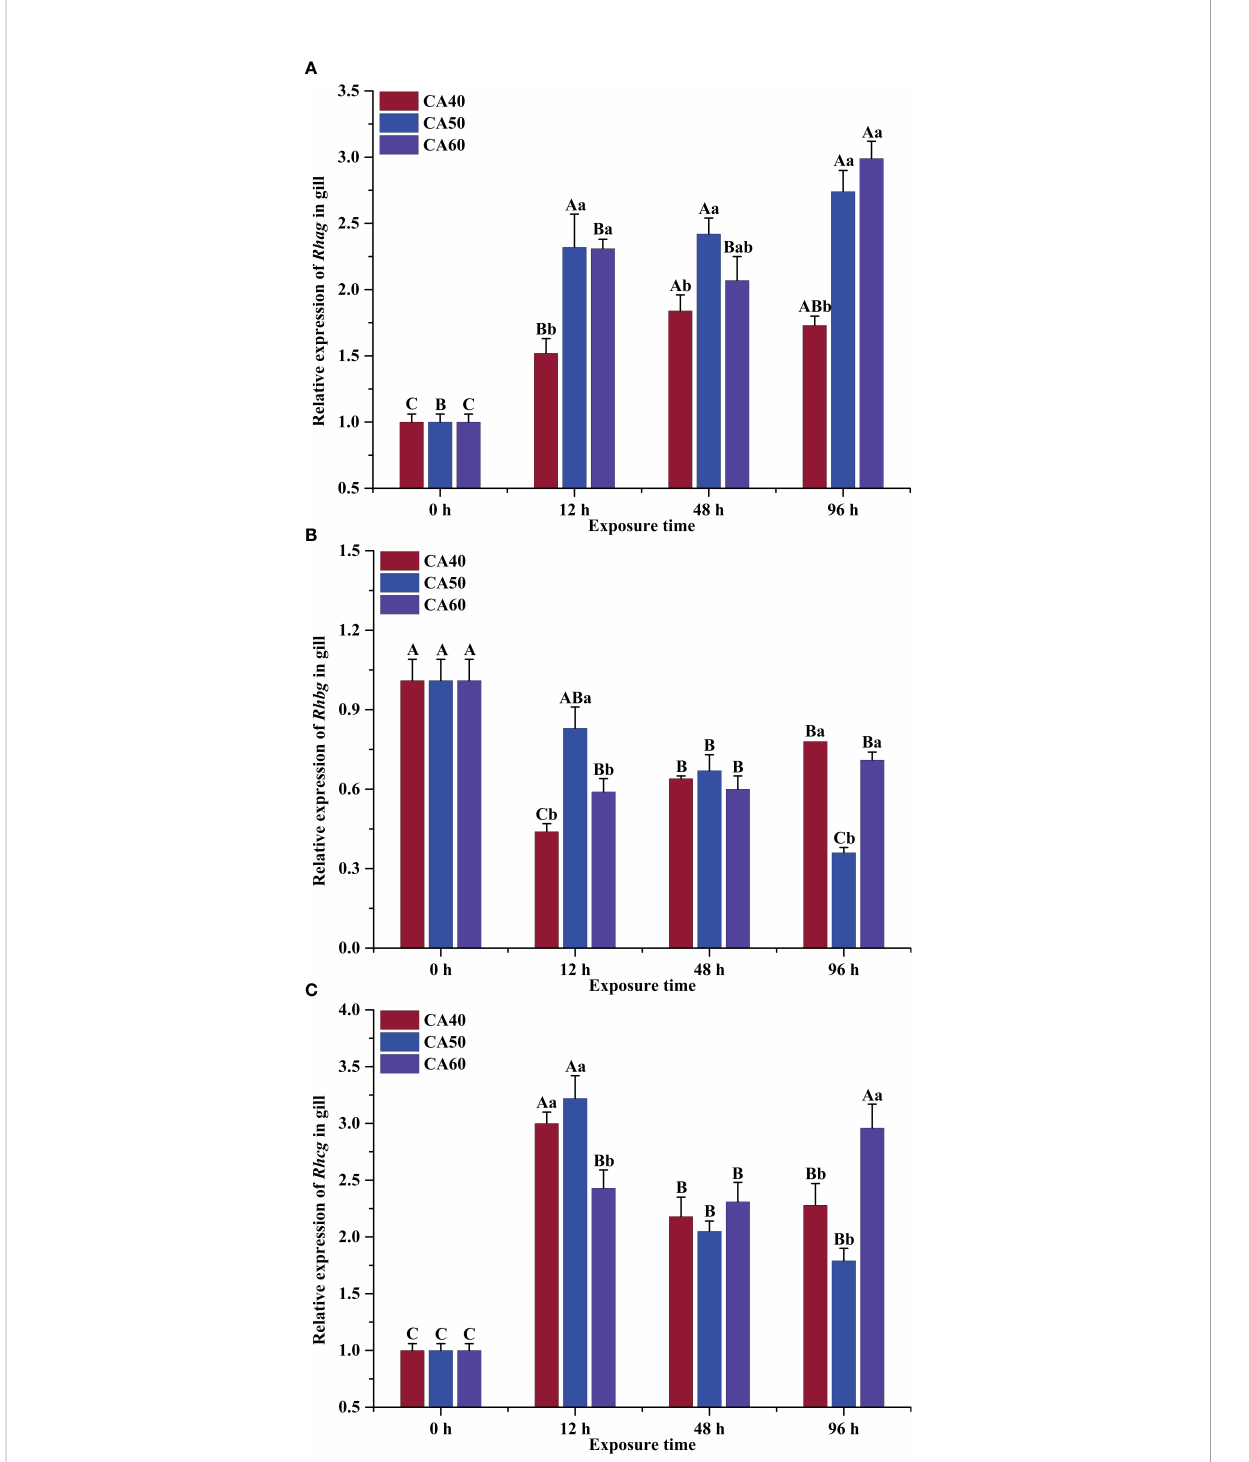
FIGURE 1 Effects of carbonate alkalinity (CA) on the relative expression of Rhag (A) , Rhbg (B) and Rhcg (C) in the gills of large-scale loach. The different capital letters are signi fi cant differences among the different exposure times in the same CA concentration. The different lowercase letters are signi fi cant differences among the different CA concentrations at the same exposure time. The bars represent the mean ± S.E.